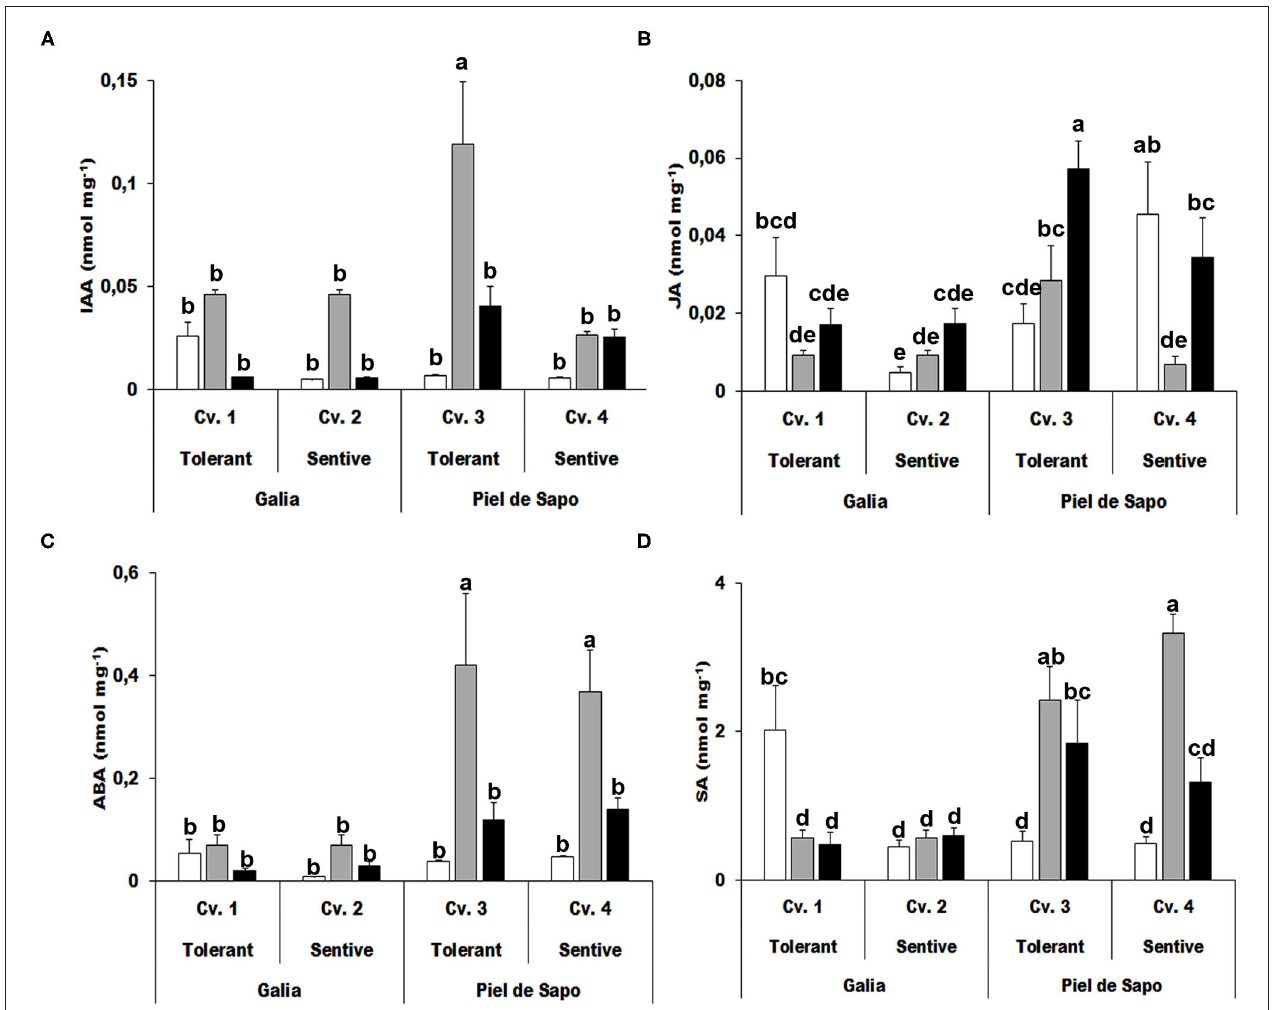
FIGURE 6 | Hormone concentrations. Indolacetic acid (IAA) (A) ; jasmonic acid (JA) (B) ; abscisic acid (ABA) (C) , and salicylic acid (SA) (D) concentrations of Galia tolerant genotype (Cv. 1), Galia sensitive genotype (Cv. 2), Piel de Sapo tolerant genotype (Cv. 3), or Piel de Sapo sensitive genotype (Cv. 4) under control (white bars), salt stress (gray bars), and drought stress (black bars) conditions. Data with different letters differ significantly ( p < 0.05), as determined by Duncan’s MRT test ( n = 5). Scale bars are mean ± SE. Experiment was replicated with similar